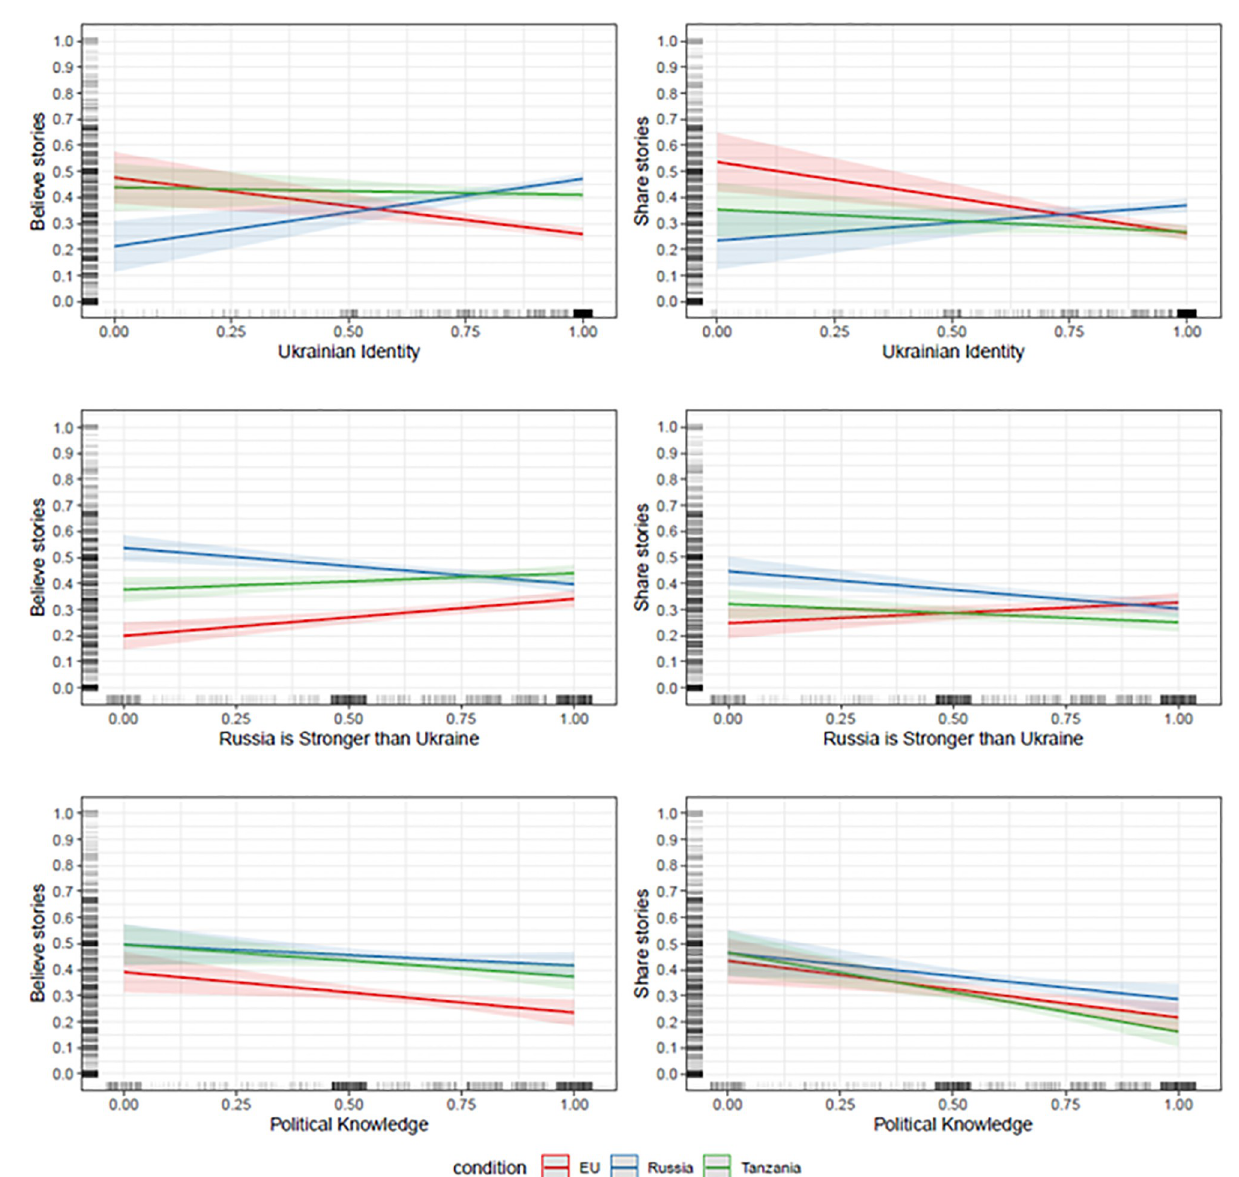
Fig 4. Predicted values of believing and intentions to share the false news with 95% confidence intervals by treatment condition and across the range of Ukrainian identity (upper panels), perceptions of power asymmetry (middle panels) and political knowledge (lower panels). Predicted values are based on OLS regression models. Ukrainian Identity, perceptions of power asymmetry and political knowledge range from 0 to 1. The dependent variables range from 0 to 1, with higher values indicating stronger beliefs the stories are true and stronger intentions of sharing the news stories. The models adjust for age, gender, educational level, employment status, political interest and perceptions of conflict between Russia and Ukraine as well as the interactions between treatment conditions and the covariates.